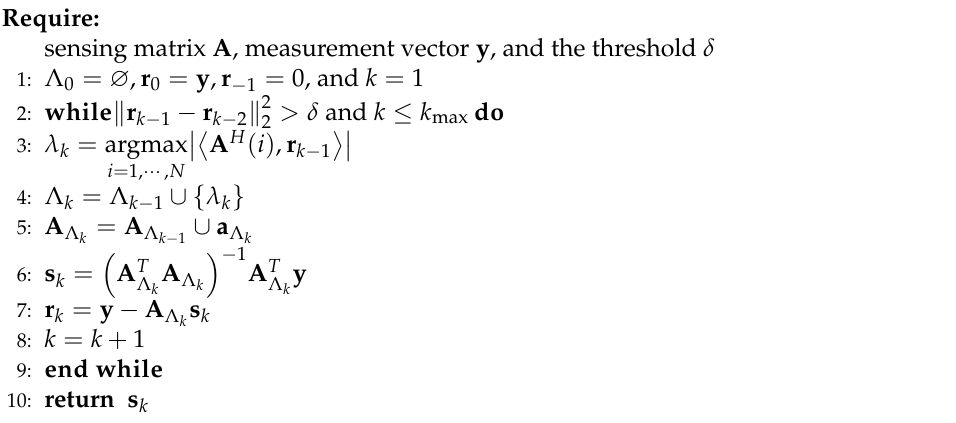
Algorithm 1 OMP Algorithm in mmWave Channels